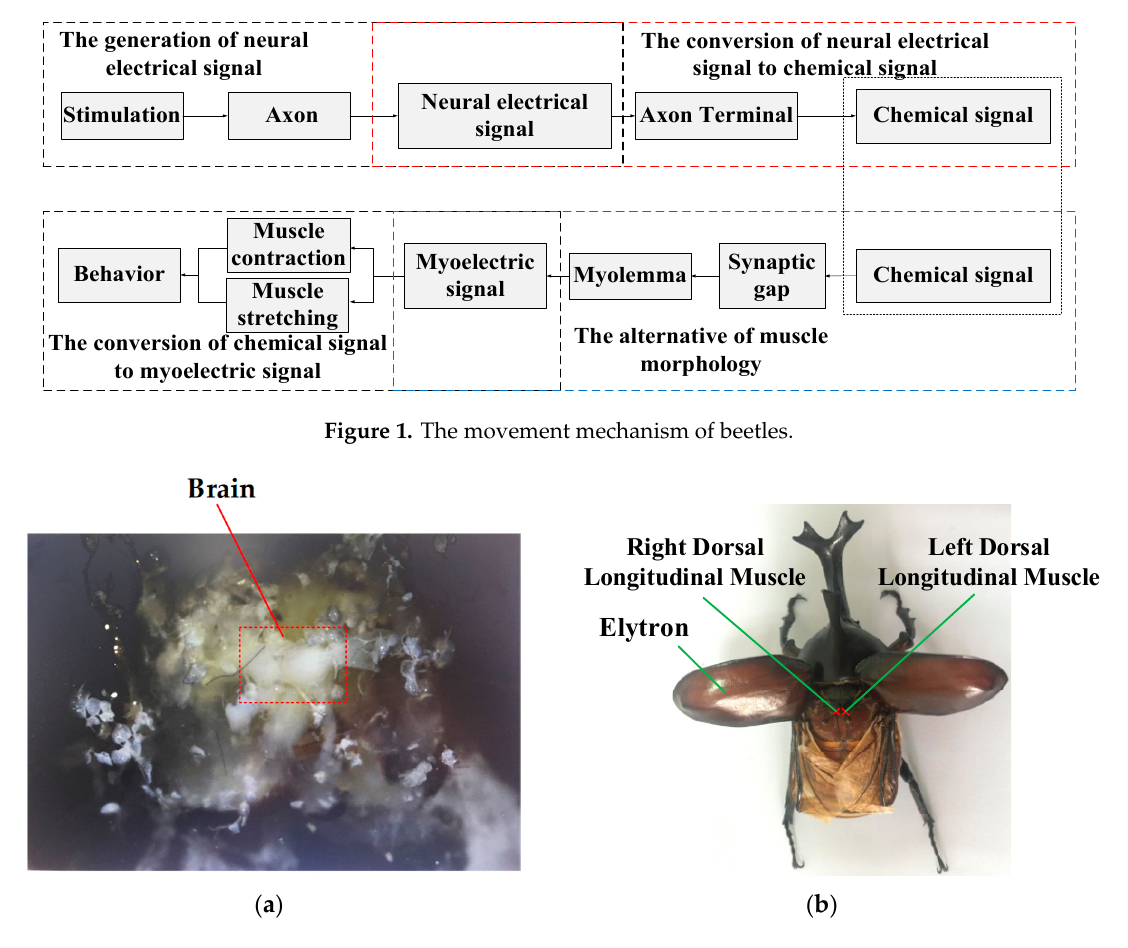
Figure 2. Beetle biological structure for flapping onset movement control system. ( a ) Movement control nerve and brain of beetle; ( b ) the left and right longitudinal dorsal muscle of beetle for implant sites.